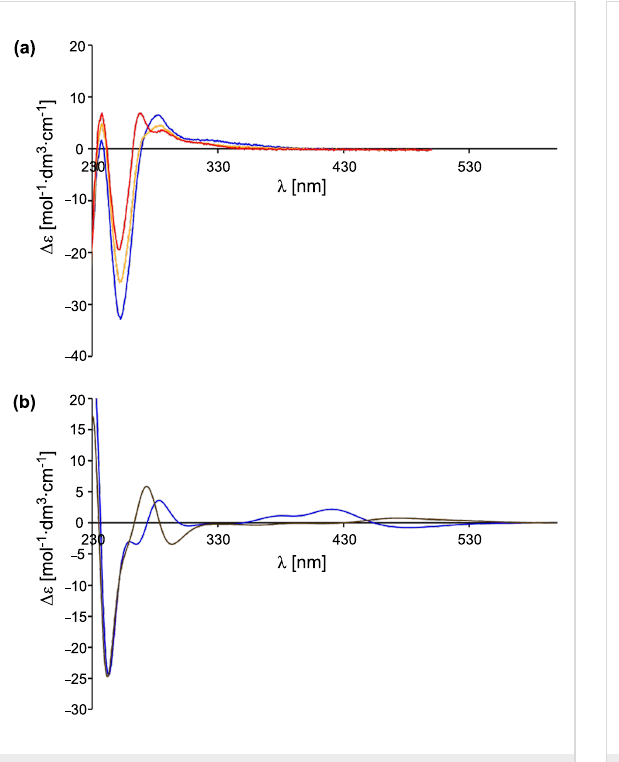
Figure 6: (a) CD spectral change of pyridine switch 13 (blue) in di- chloromethane (c = 5.6 × 10 –5 M) at 20 °C upon addition of 10 (yellow) and 30 equiv TFA ( 12 , red). (b) Calculated spectra of ( M )- 13 (blue) and ( P )- 13 (brown) by using TD-DFT-B3LYP/6-31G*.